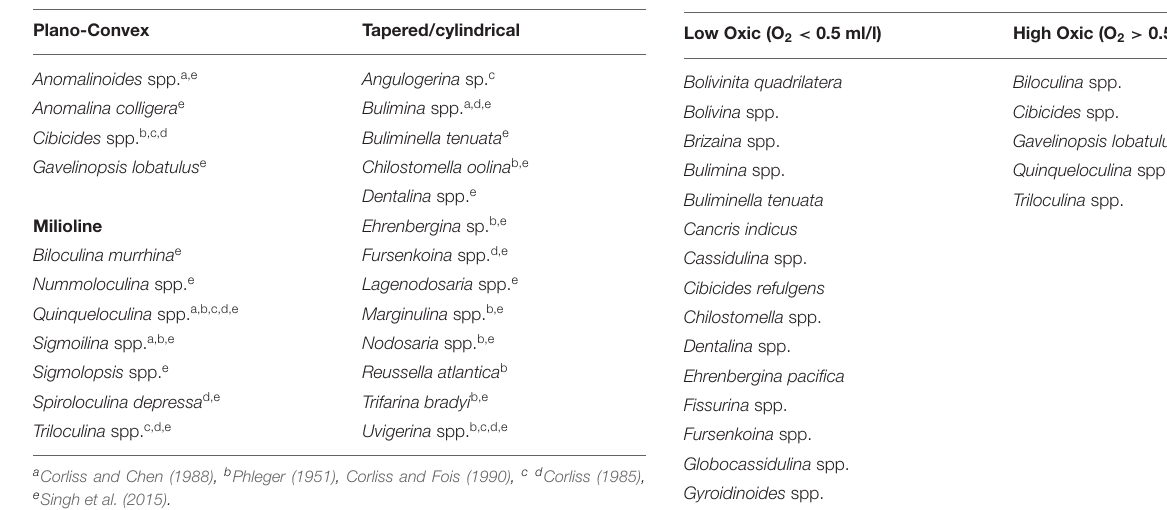
TABLE 4 | Constituent species of low O 2 ( < 0.5 ml/L O 2 ) and high O 2 ( > 0.5 ml/L